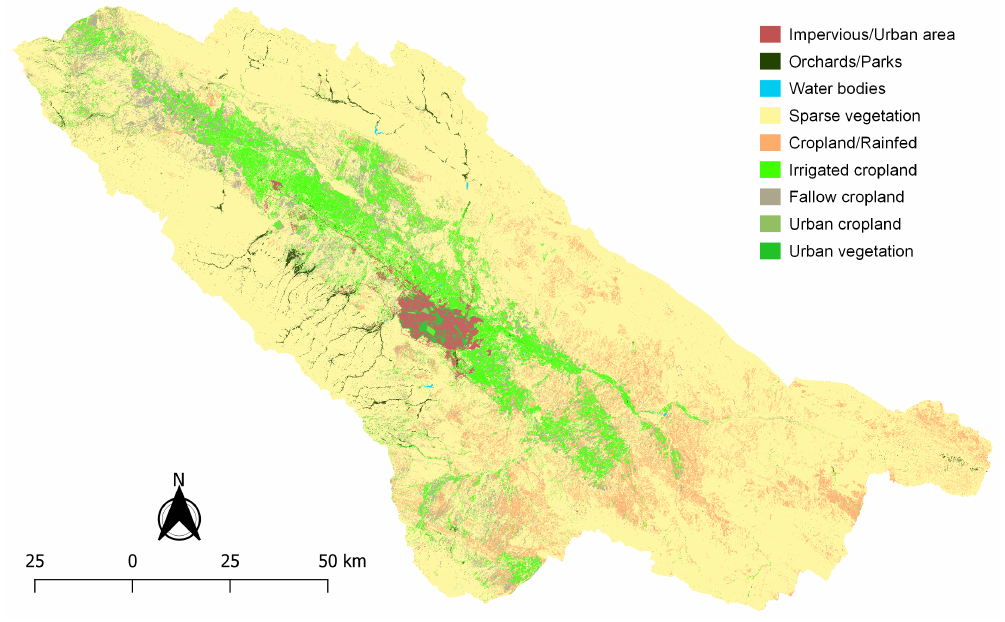
Figure 8. Classified land cover map of Mashhad basin for